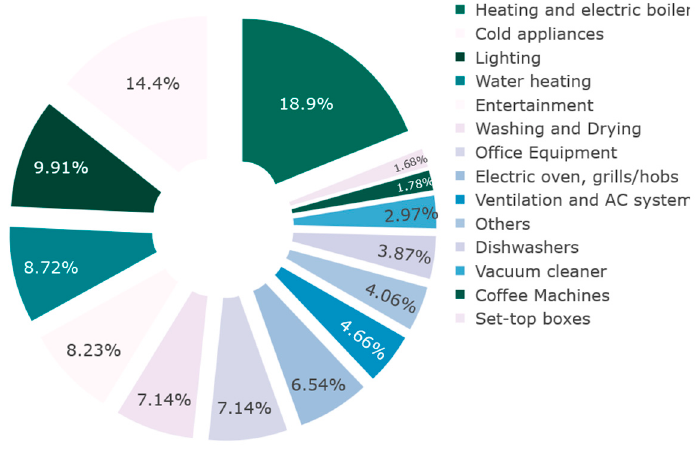
Figure 1. Residential electricity consumption breakdown in the European Union 27 (EU-27), own source based on [3].